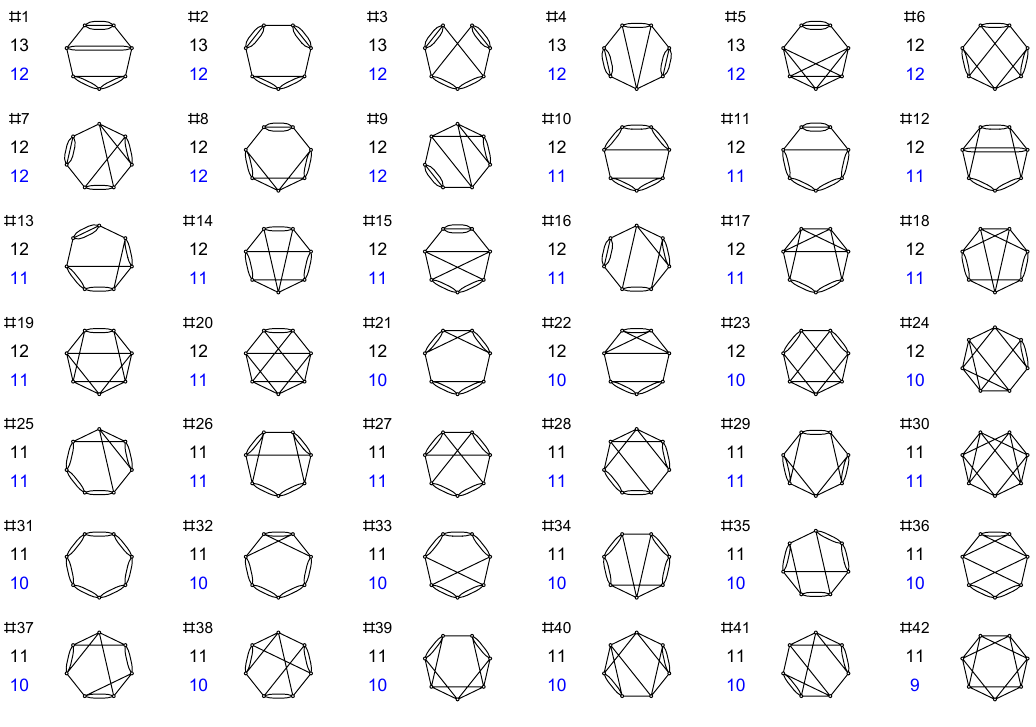
Figure 7 . All vacuum diagrams of order g 7